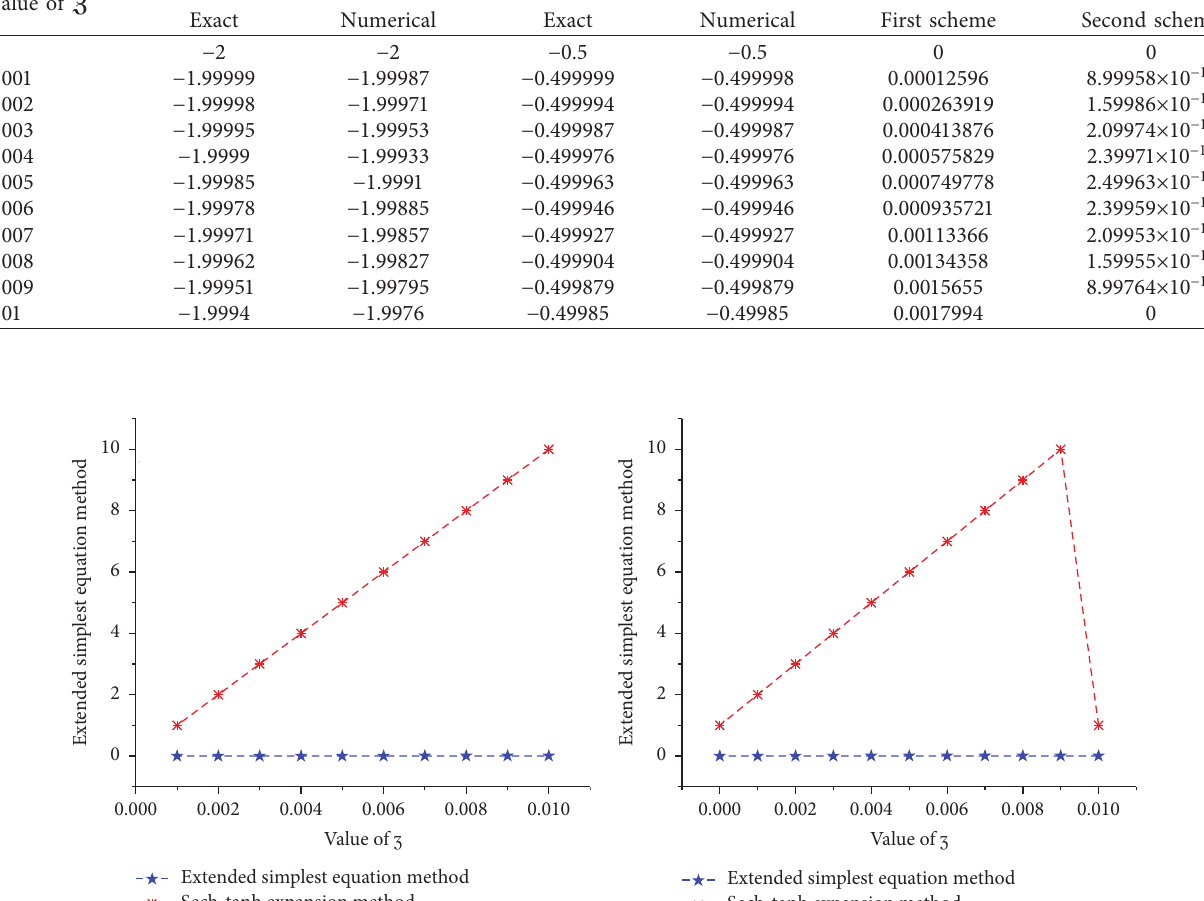
Table 2: Exact, numerical, and absolute value of error with different value of Z with respect to the obtained solution via the extended simplest equation method (18) and sech-tanh method (31) via the cubic B-spline scheme. Value of Z